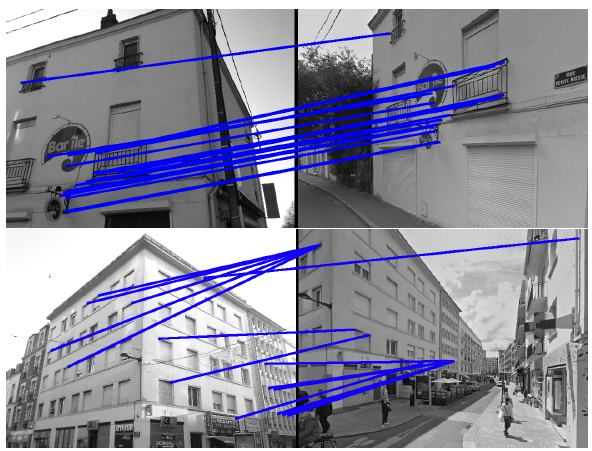
Figure 14. Geolocalization detection using the whole